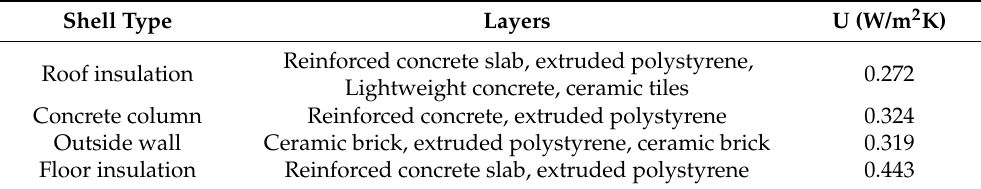
Table A1. Insulation data (U-values) for the building envelope (reinforced concrete